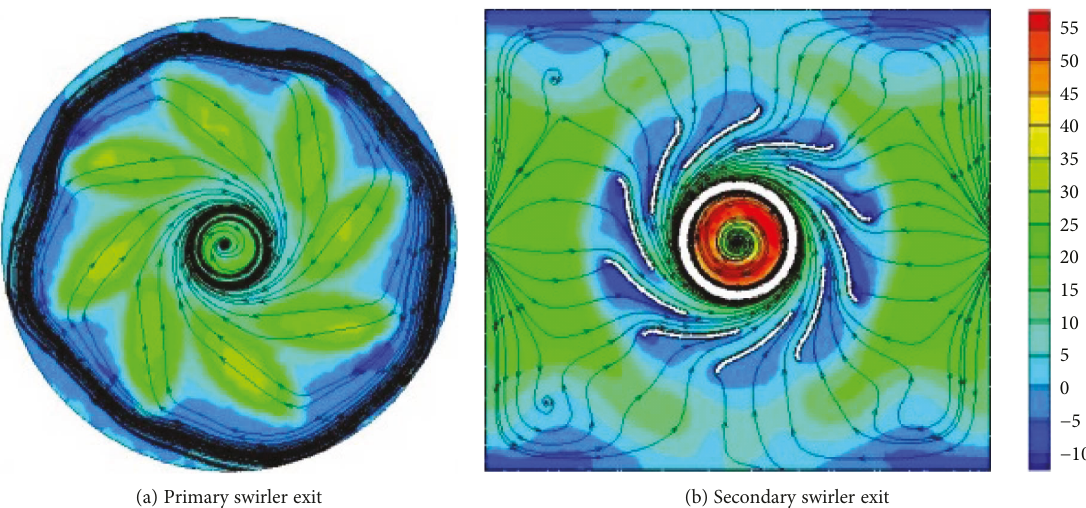
Figure 12: The streamlines and axial velocity contours for the plane cutting through the primary